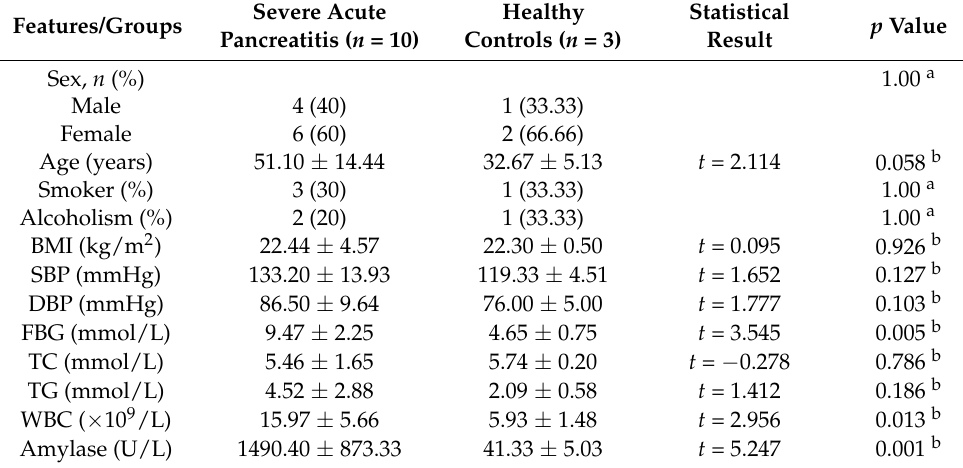
Table 1. Baseline characteristics of patients with severe acute pancreatitis and healthy controls.